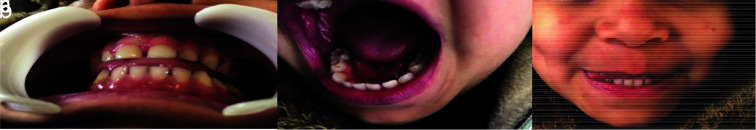

a: Gingival lesion was recovered, b: The oral aphthous lesions of the patient after 10 days of conservative therapy, c: Pallor malar rash